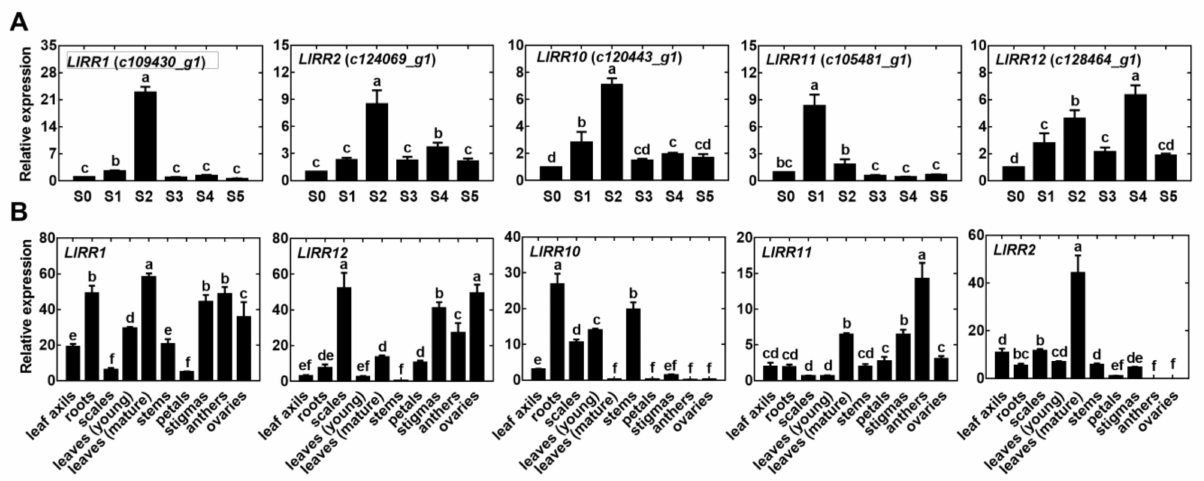
Figure 4. Expression patterns of five type-B LlRR s in L. lancifolium . ( A ) The expression of five type-B LlRR s during bulbil formation. The stages of bulbil formation were divided into the bulbil initiation stage (S0–S2), the bulbil primordium formation stage (S3–S4) and the bulbil structure formation stage (S5). ( B ) The expression of five type-B LlRR s in different tissues. Values are means ± SDs ( n = 3). Lowercase letters (a–d in A ; a–f in B ) indicate statistically significant differences at p <